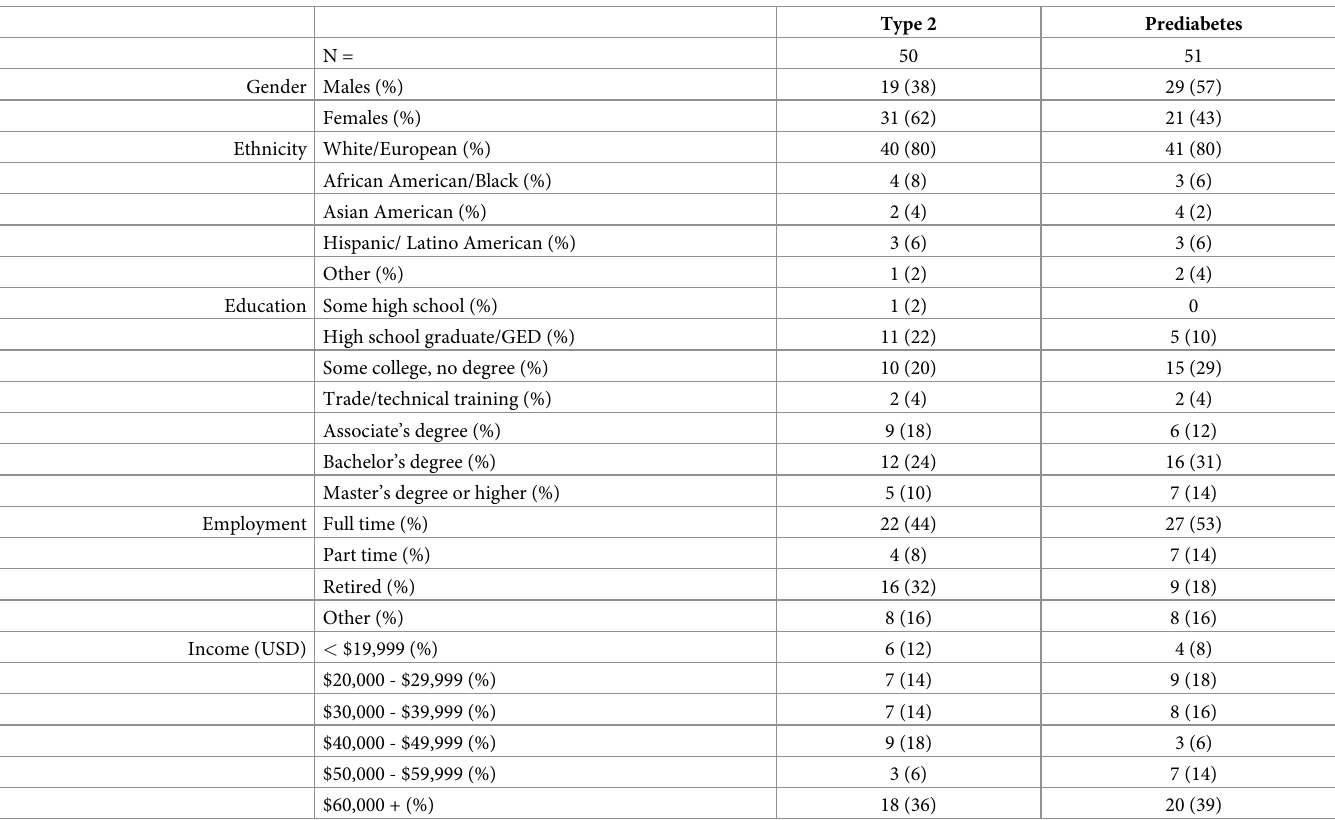
Table 1. Descriptive demographic